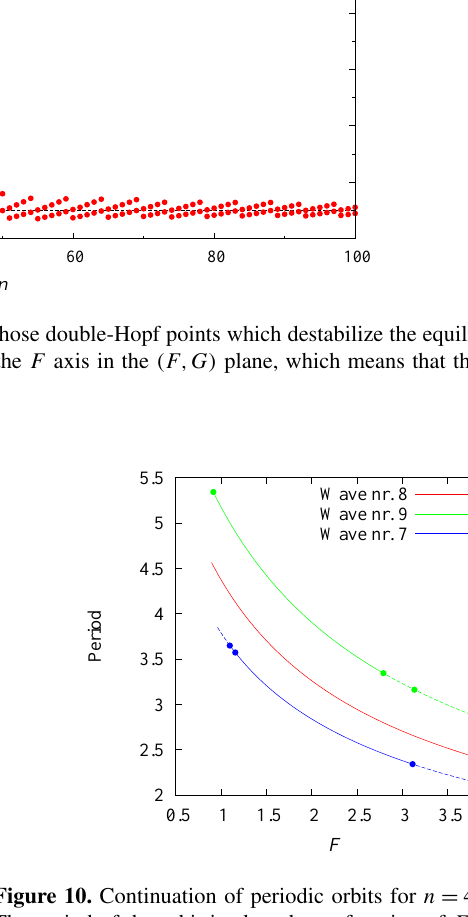
Figure 10. Continuation of periodic orbits for n = 40 and G = 0. The period of the orbit is plotted as a function of F . Stable (resp. unstable) orbits are indicated by solid (resp. dashed) lines. Circles denote Ne˘ımark-Sacker bifurcations and triangles denote period doubling bifurcations. The Hopf bifurcations generating the waves with wave numbers 8, 9, and 7 occur at respectively F = 0 . 894, F = 0 . 902, and F = 0 . 959. Clearly, for 1 . 15 < F < 2 . 79 three sta- ble periodic orbits